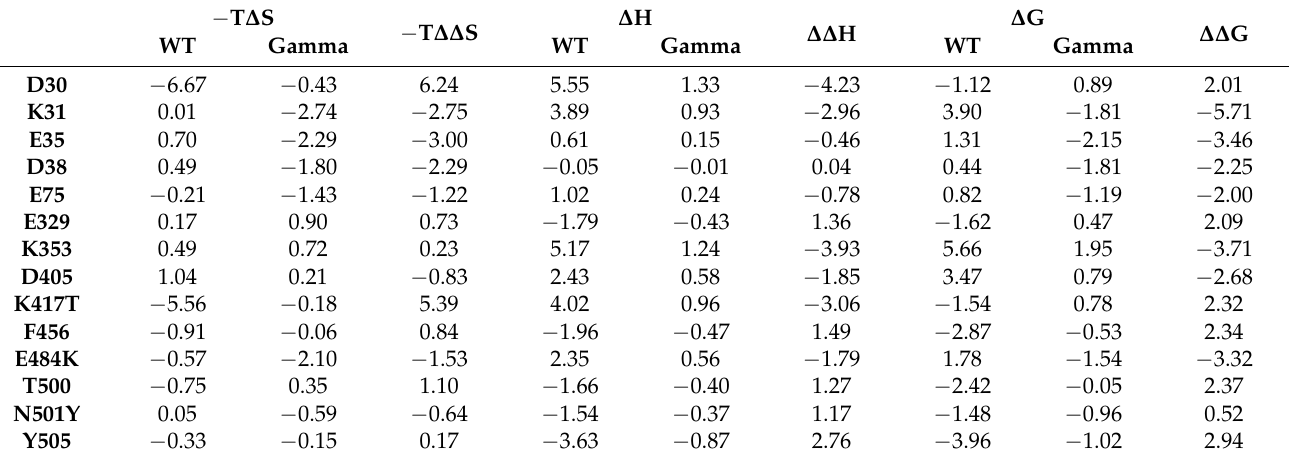
Table 4. Major residue contributions to the free energy ( ∆ G). Free energy changes with a cut-off − 2 ≤ and ≥ 2 with the exception of N501Y mutation. The free energy compensation is highlighted in red for the K417T, E484K and N501Y mutations. All values are in kcal/mol. Shaded cells correspond to hACE-2